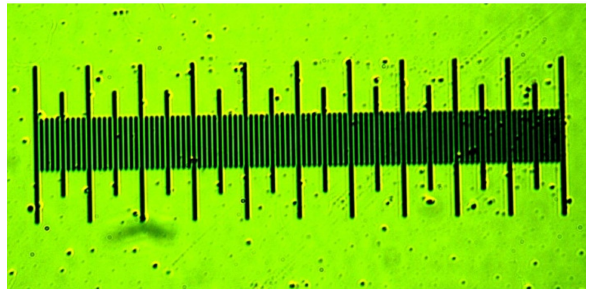
Figure 4. Image of a scale for